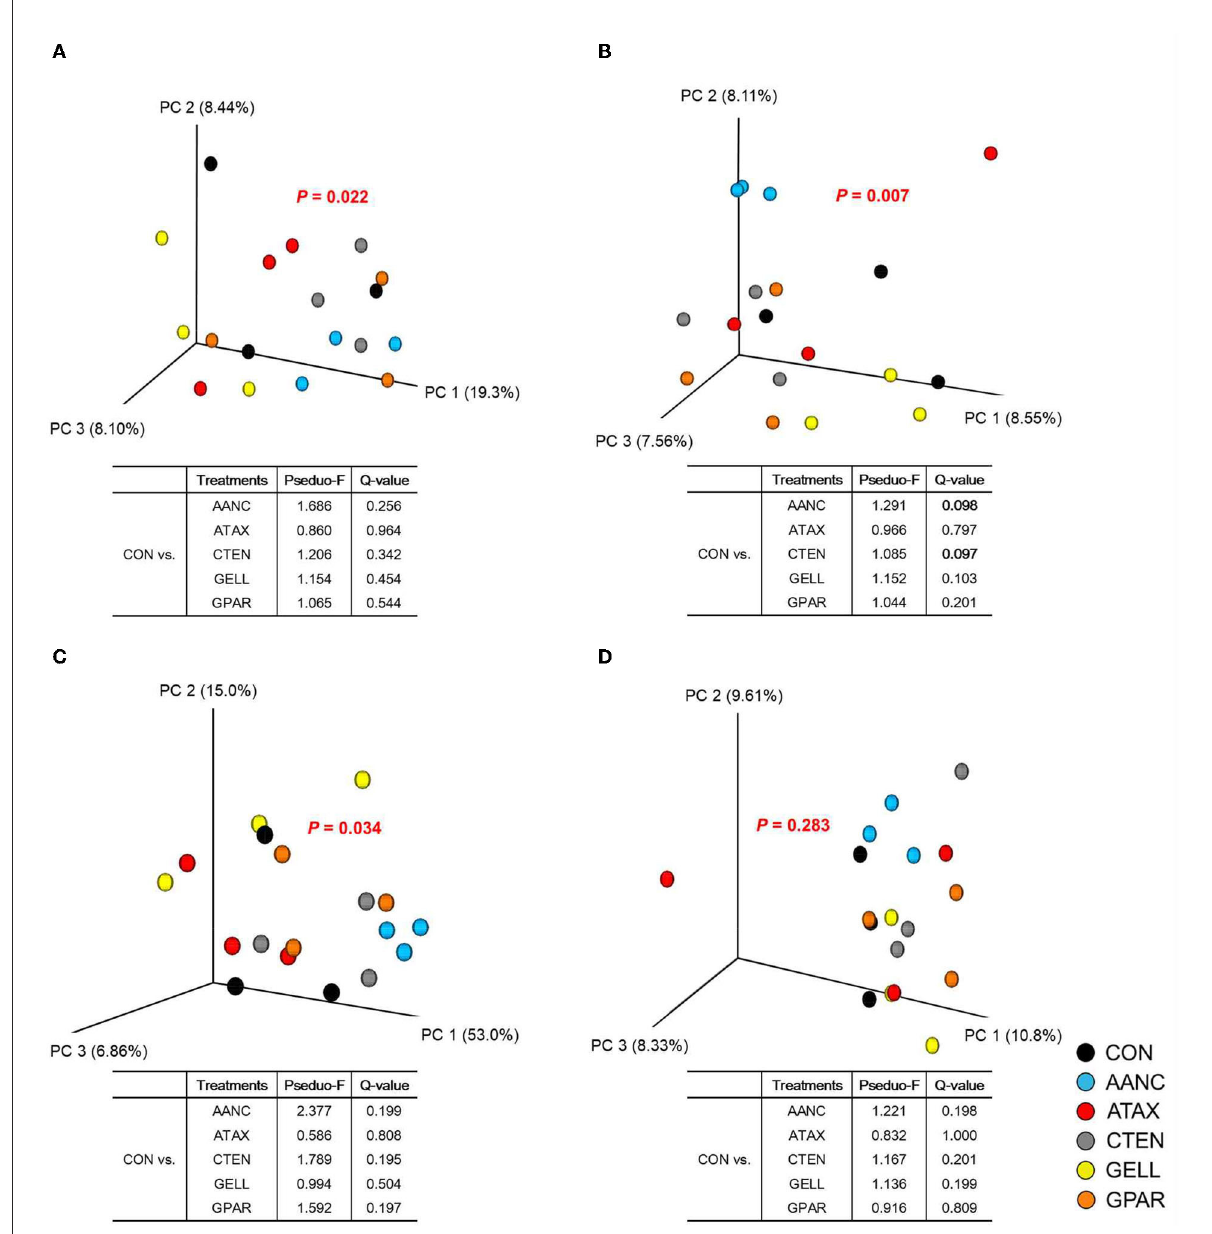
FIGURE4 Principal coordinates analysis based on the (A) Bray-Curtis, (B) Jaccard, (C) Weighted Unifrac, and (D) Unweighted Unifrac distances of the red seaweed extracts in the in vitro cultures. PERMANOVA results of the pairwise comparison of the overall microbiota structures between the control and each red seaweed treatment were included (after 24h of in vitro incubation). CON (black circle), without seaweed extracts; AANC (sky blue circle), Amphiroa anceps ; ATAX (red circle), Asparagopsis taxiformis ; CTEN (dark gray circle), Chondracanthus tenellus ; GELL (yellow circle), Grateloupia elliptica ; GPAR (orange circle), Gracilaria parvispora .